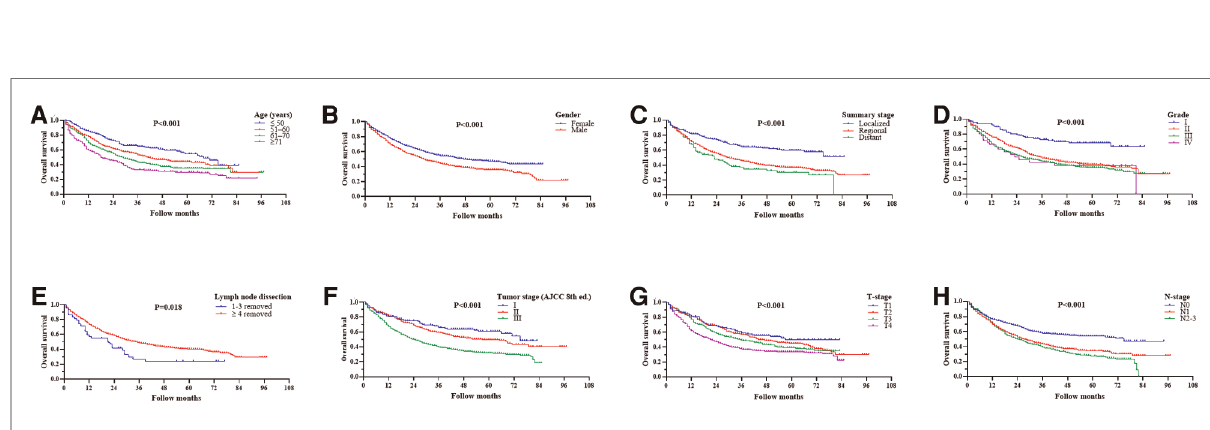
FIGURE 3 (Top row) Kaplan – Meier survival curves for chemotherapy in patients with non-small cell lung cancer (NSCLC) after a PN. ( A ) Before propensity score matching (PSM), HR: 0.745; 95% CI 0.641 – 0.867; P <0.001; ( B ) after PSM, HR: 0.791; 95% CI 0.676 – 0.925; P =0.003. (Bottom row) Kaplan – Meier survival curves for radiotherapy in NSCLC patients after PN. ( C ) Before PSM, HR: 1.261; 95% CI 1.054 – 1.507; P =0.011; ( D ) after PSM, HR: 1.167; 95% CI 0.970 – 1.405; P =0.102.